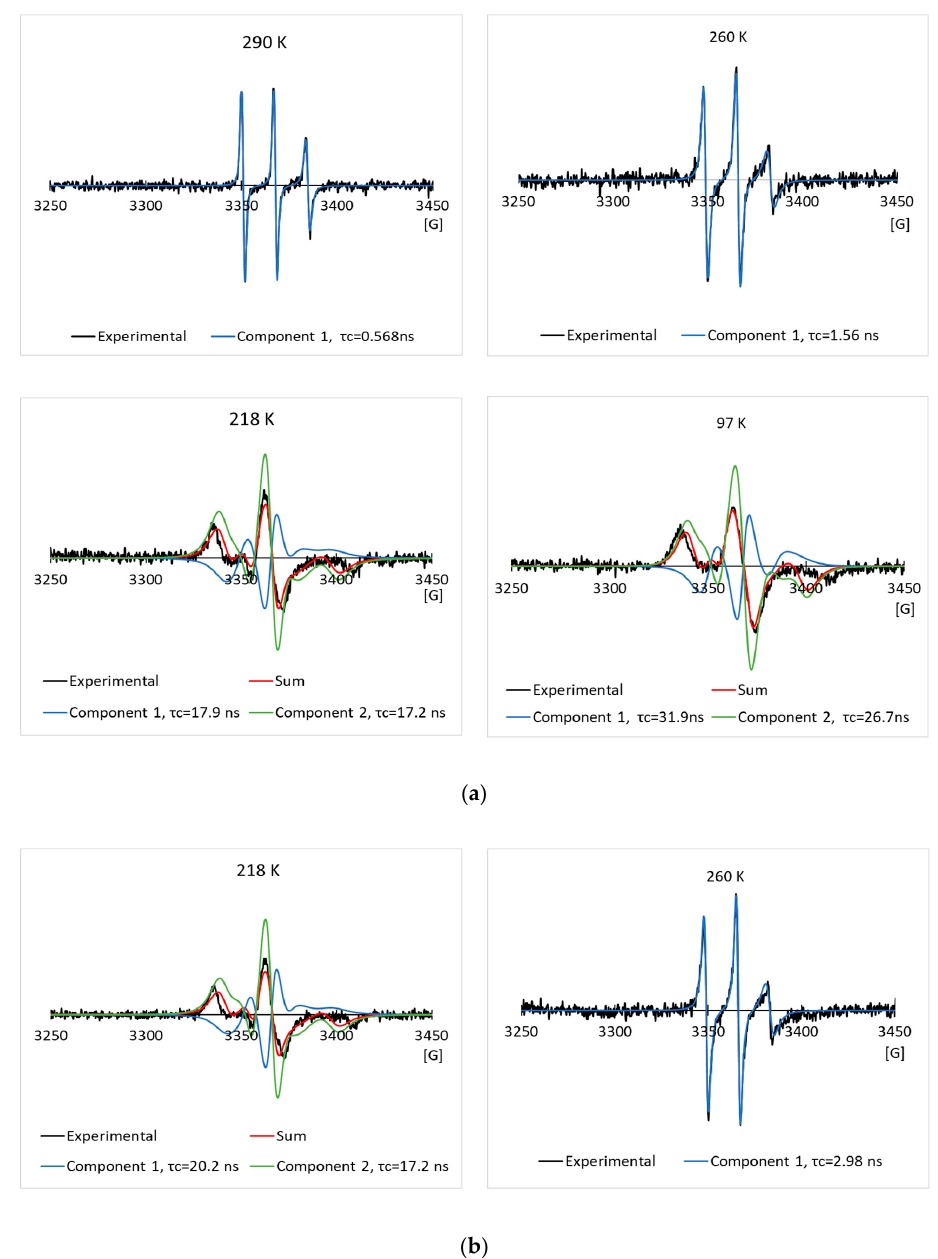
Figure 6. Typical experimental EPR spectra, and their simulated EPR spectra of the 2.0 mg / mL spin labeled A17C in the 5% glycerol solution in the freezing process ( a ), and melting process ( b ),